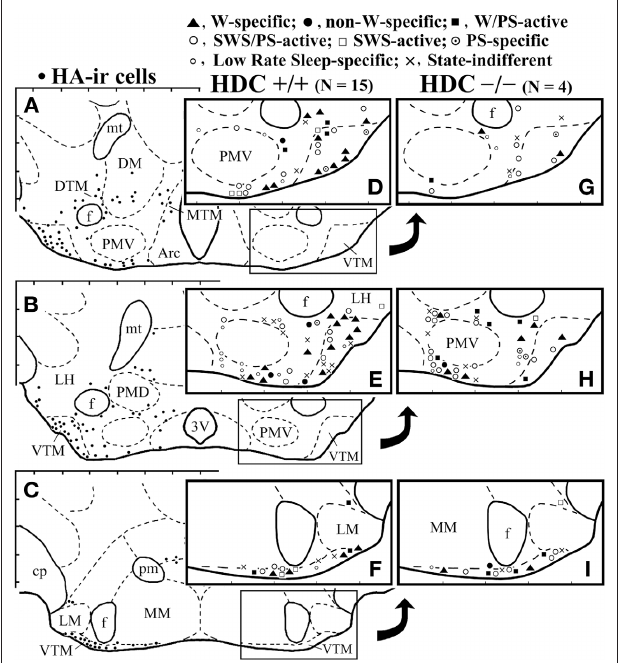
Figure 1 | Camera lucida drawings of frontal sections showing the distribution of histamine-immunoreactive neurons (dots, A–C) and those of W-specific, non-W-specific, W/PS-active, SWS/PS-active, SWS-active, PS-specific, Low rate sleep-specific, and state-indifferent neurons recorded in WT (D–F) or HDC-KO (g–i) mice. 3V, third ventricle; Arc, arcuate nucleus; cp, cerebral peduncle; DM, dorsomedial hypothalamic nucleus; DTM, MTM, and VTM, diffuse, medial, and ventral tuberomammillary nucleus, respectively; f, fornix; LH, lateral hypothalamic area; MM and LM, medial and lateral mammillary nucleus; respectively; mt, mammillothalamic tract; PMD and PMV, dorsal and ventral premammillary nucleus, respectively.